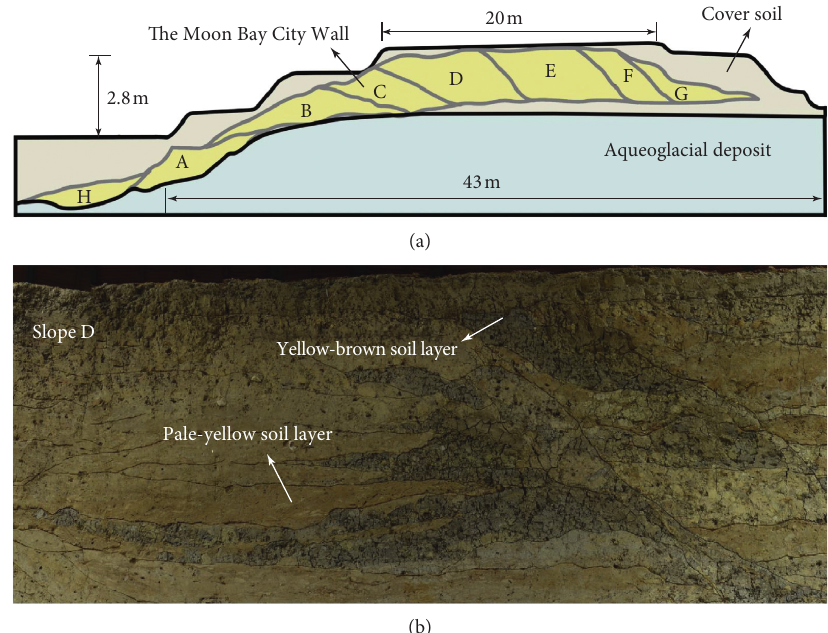
Figure 2: The profile of the Moon Bay City Wall. (a) A section of Moon Bay City Wall. (b) Slope D of the above section.